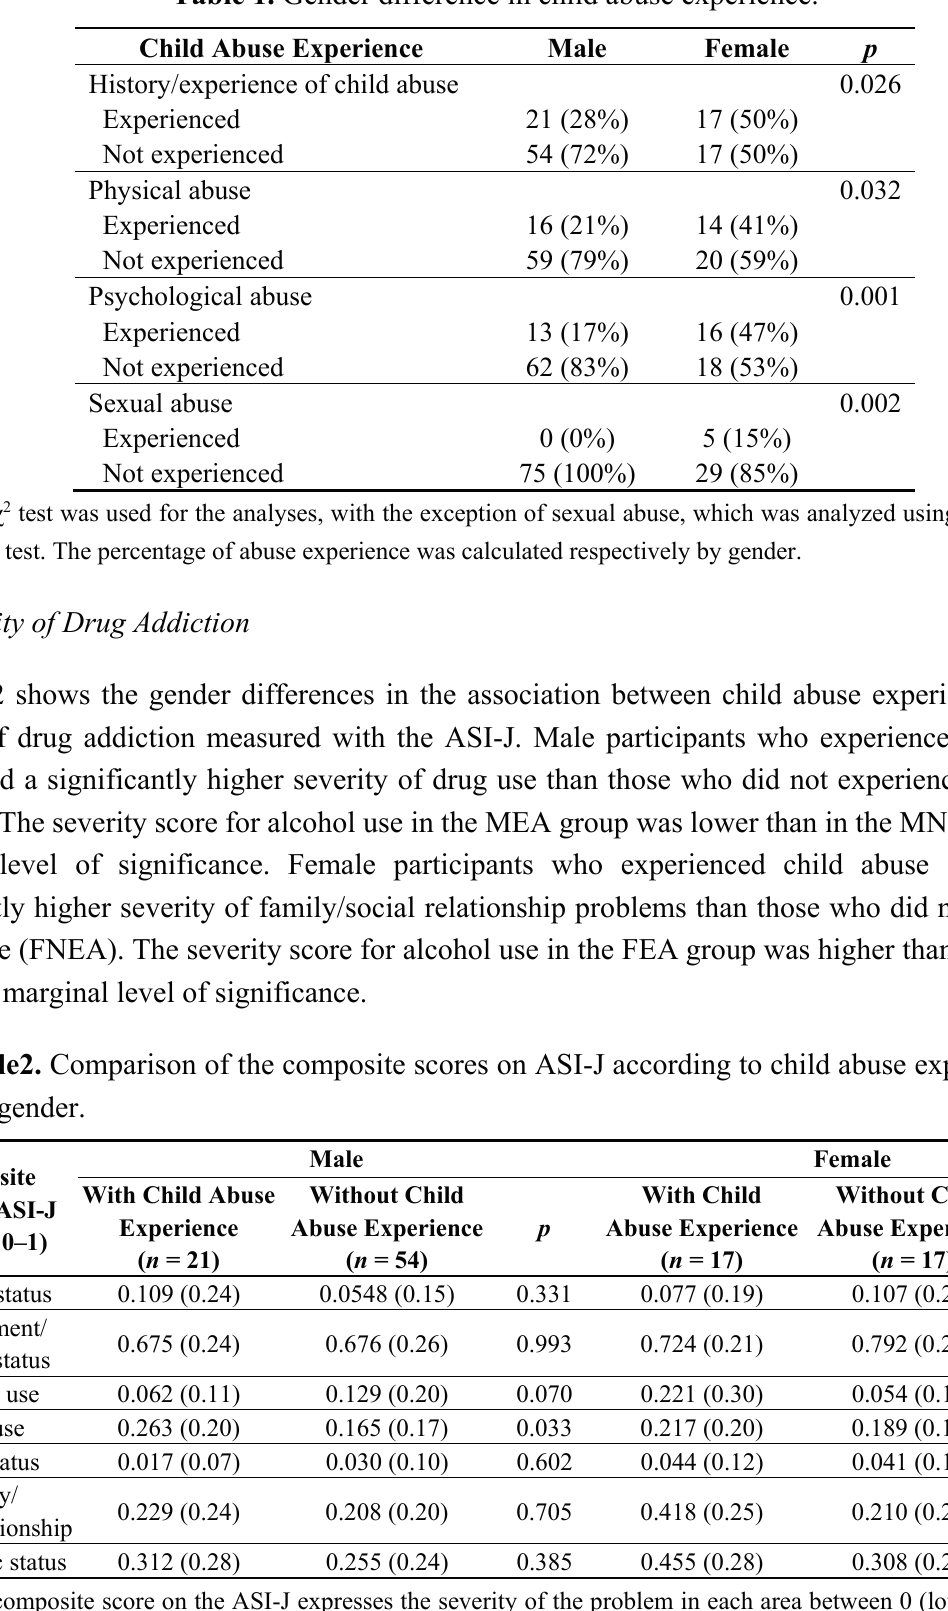
Table 1. Gender difference in child abuse experience.